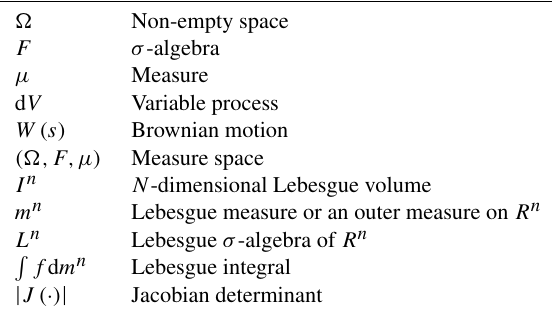
Table A1. Basic notations.